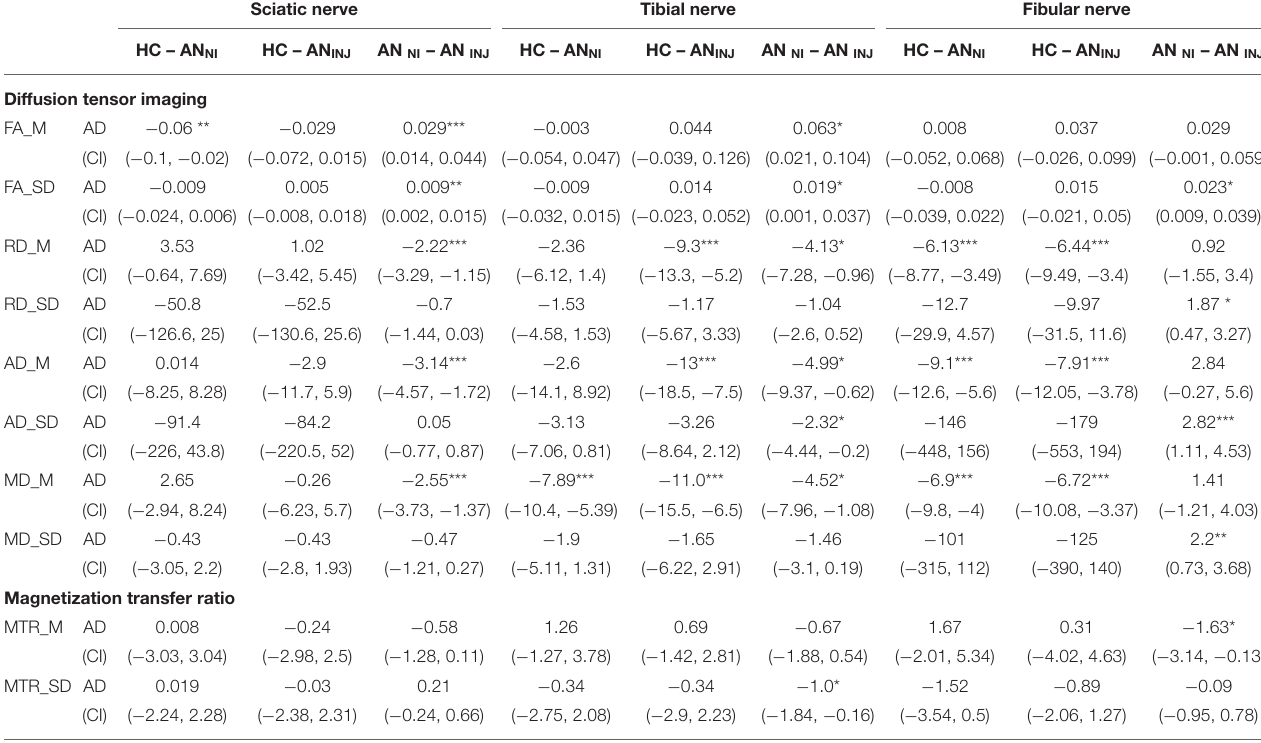
TABLE 2 | Peripheral nerve